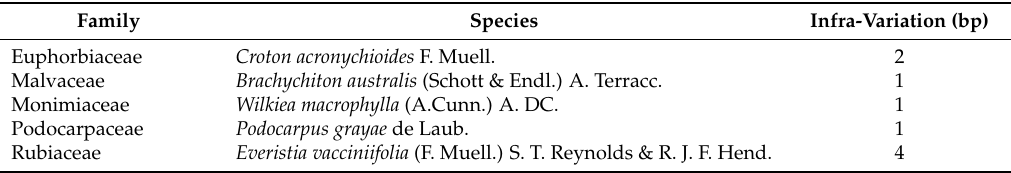
Table 2. List of species showing infraspecific variation across the Burdekin Gap. Infraspecific variation (column 3) tallied by total number of base pair (bp) differences within each species across all three barcode loci.